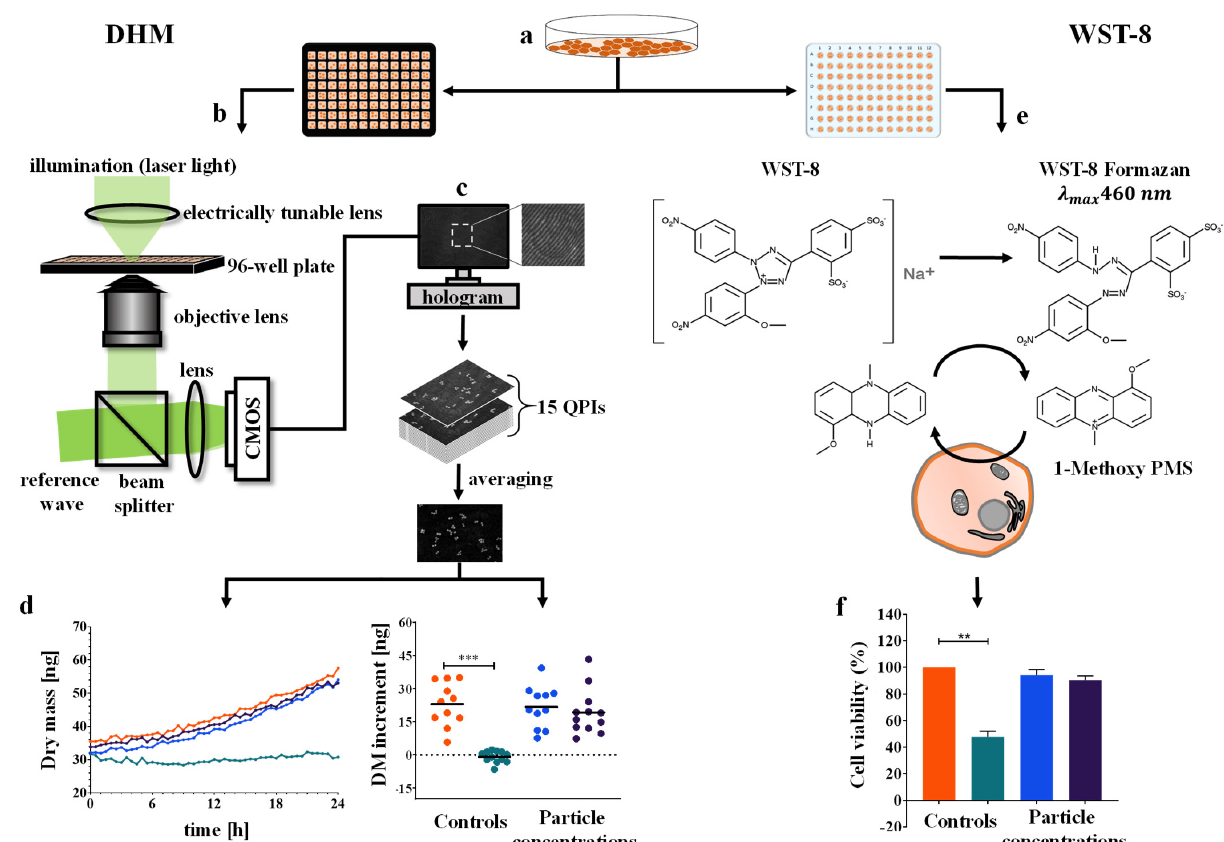
Figure 1. Experimental workflow of the DHM in vitro assay for cytotoxic effect quantification of organic nanoparticles in development for medical use and WST-8 cell viability assay. ( a ) Cell lines were transferred from cell culture vessels to 96-well imaging and assay plates for microscopic and colorimetric viability assays. ( b ) DHM measurements were performed with a modular off-axis setup based on an inverted research microscope and the sample placed inside a stage-top incubator. Sequences of 15 DHM QPI images with modulated object illumination via an electrically tunable lens were acquired immediately after nanomaterial incubation at n = 4 measurement positions per well every 30 min for 24 h. ( c ) The QPI image sequences of 15 quantitative phases at each individual measurement point per position were averaged to reduce the impact of coherence-induced image disturbances that are induced by the laser light. ( d ) For each experiment, the temporal dry mass course and the dry mass increments after 24 h in 12 fields of view from three independent experiments were determined from the averaged QPI images, and subsequently, the mean values were calculated. ( e ) Experimental procedure for the WST-8 viability assay. Colorimetric readout of 24 technical repeats total per concentration in three independent experiments was performed after 24 h of incubation with nanoparticles and controls. ( f ) Effects, quantified in three independent experiments, were reported as viability percentages of medium control cells. **,***: Statistical significances were determined for both assays.